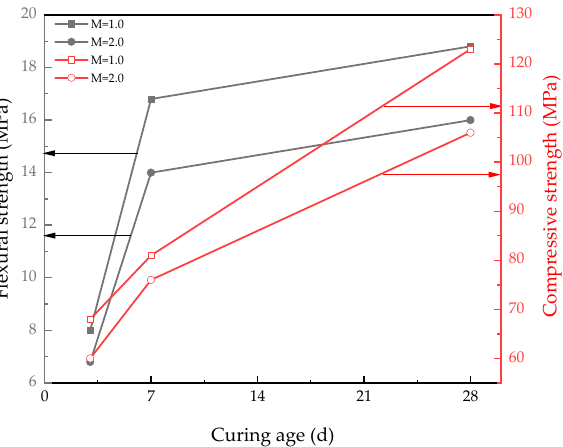
Figure 6. Mechanical strengths of alkali-activated BFS with different curing age and modulus.